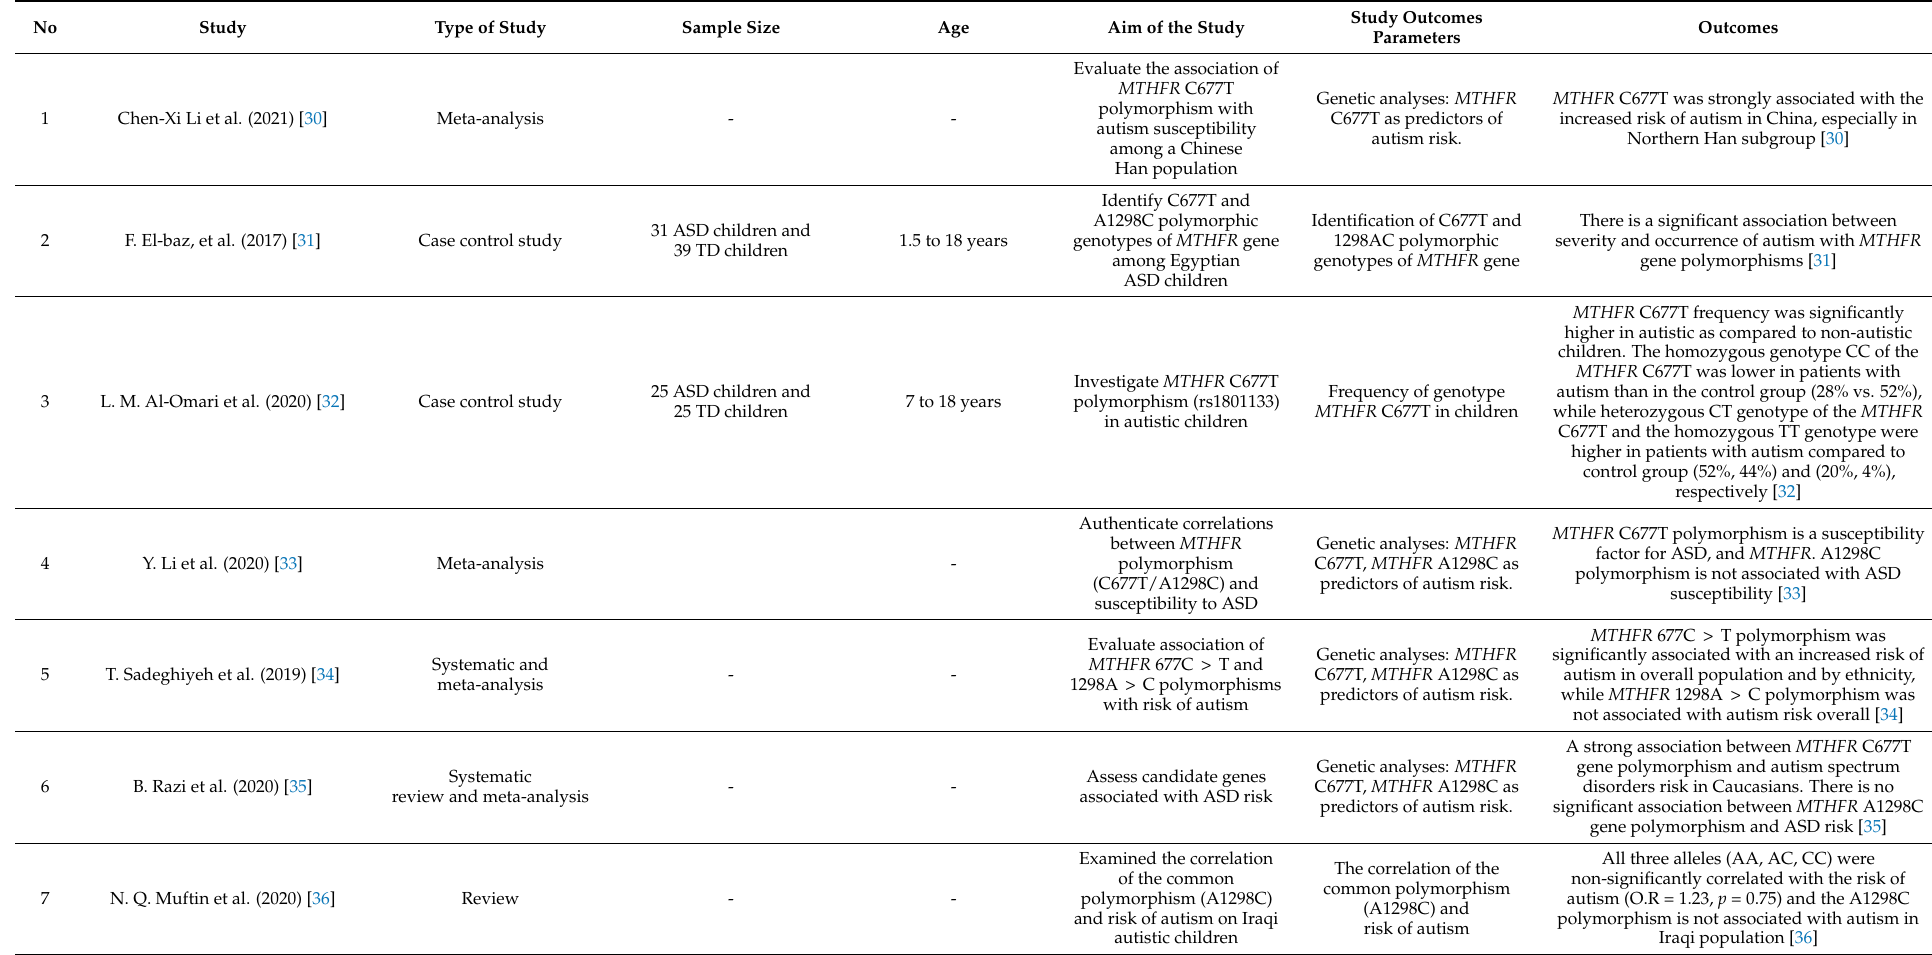
Table 3. Studies on the genetic predisposition of